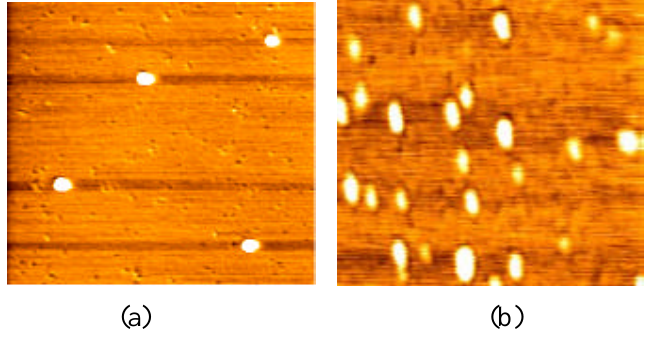
Figure 1. Monomolecular images of Ig G1 and Ig G1+Ig G2 (a. Ig G1; b. Ig G1+Ig